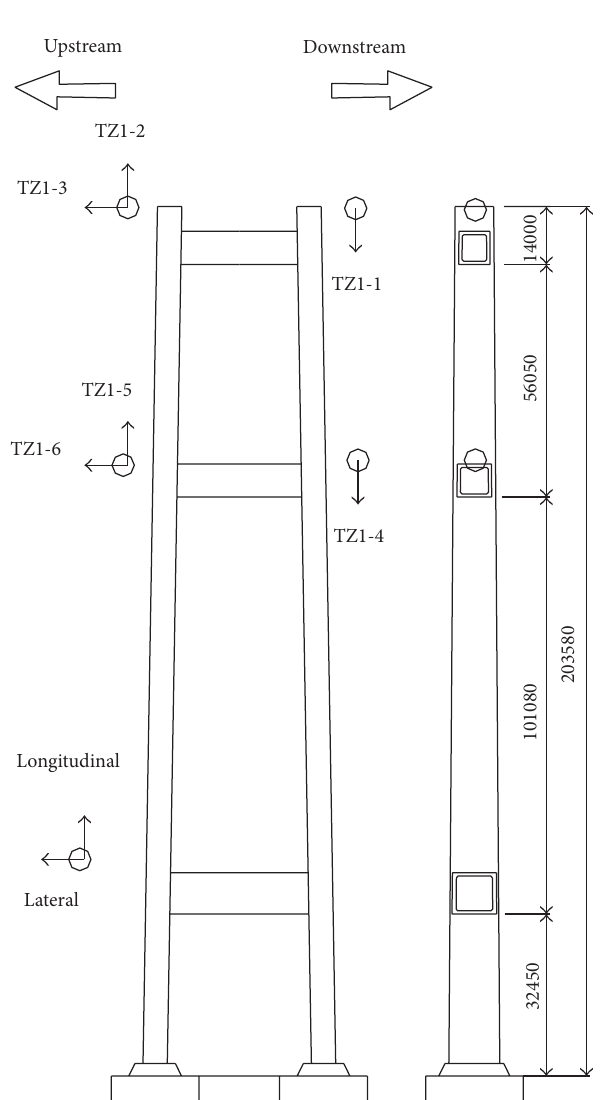
Figure 9: Layout of the accelerometers on the main tower of RSB (dimension unit: